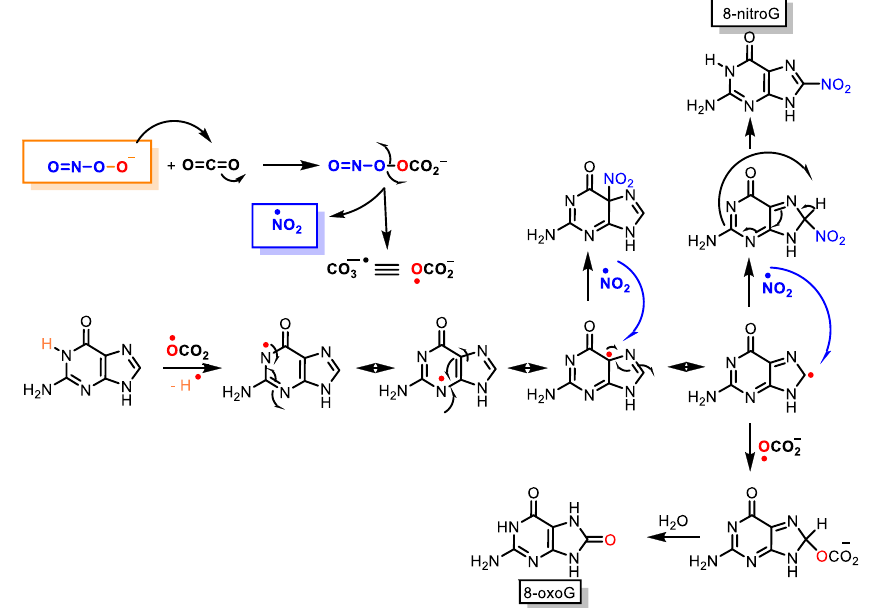
Figure 10. Guanine reactions with peroxynitrite to 8-oxoguanine and 8-nitroguanine.